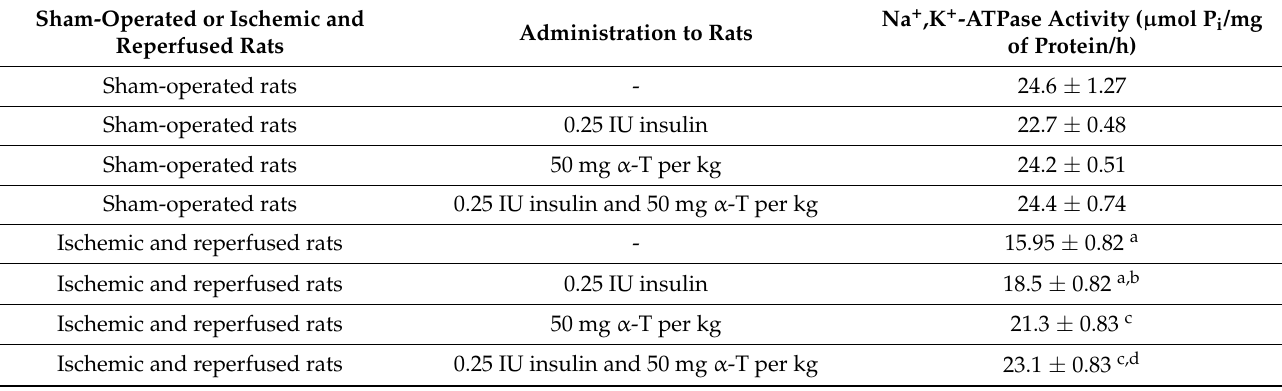
Table 2. The effect of intranasally administered insulin and per-orally administered α -T on Na + ,K + -ATPase activity in brain cortex of rats with two-vessel ischemia followed by reperfusion ( µ mol P i /mg of protein/h). Sham-Operated or Ischemic